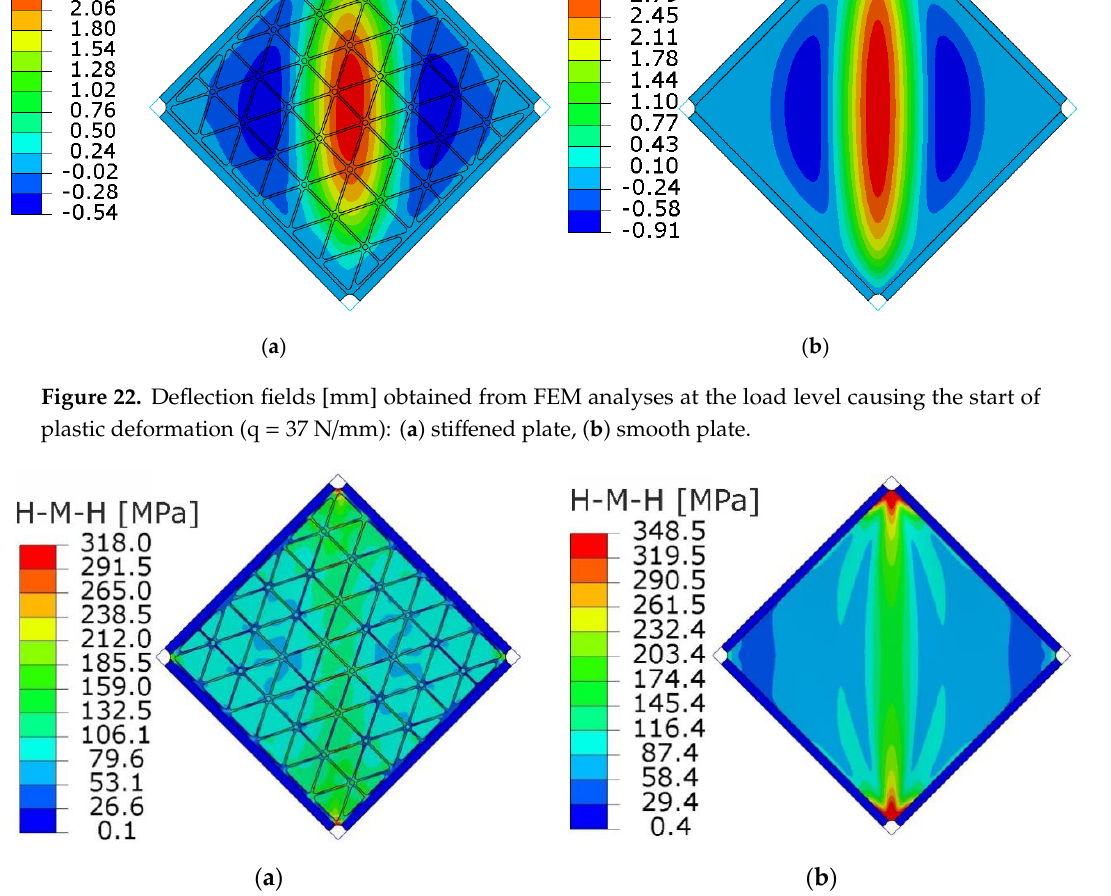
Figure 23. HMH stress distribution (MPa) obtained from FEM analyses at the load level causing the start of plastic deformation (q = 37 N/mm): ( a ) stiffened plate, ( b ) smooth plate.